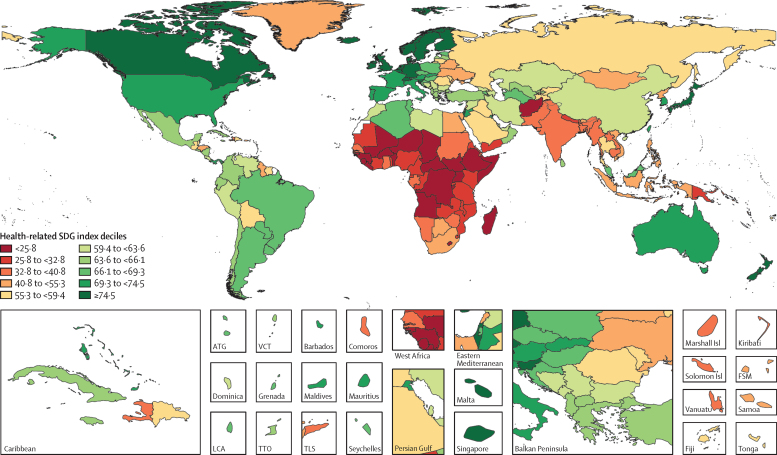
Health-related SDG index by decile, 2017Deciles are based on the distribution of health-related SDG indices for countries and territories in 2017. ATG=Antigua and Barbuda. FSM=Federated States of Micronesia. Isl=Islands. LCA=Saint Lucia. SDG=Sustainable Development Goal. TLS=Timor-Leste. TTO=Trinidad and Tobago. VCT=Saint Vincent and the Grenadines.